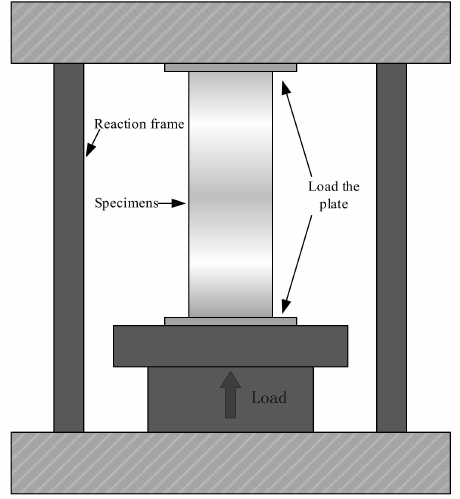
Figure 3. Schematic diagram of the test loading